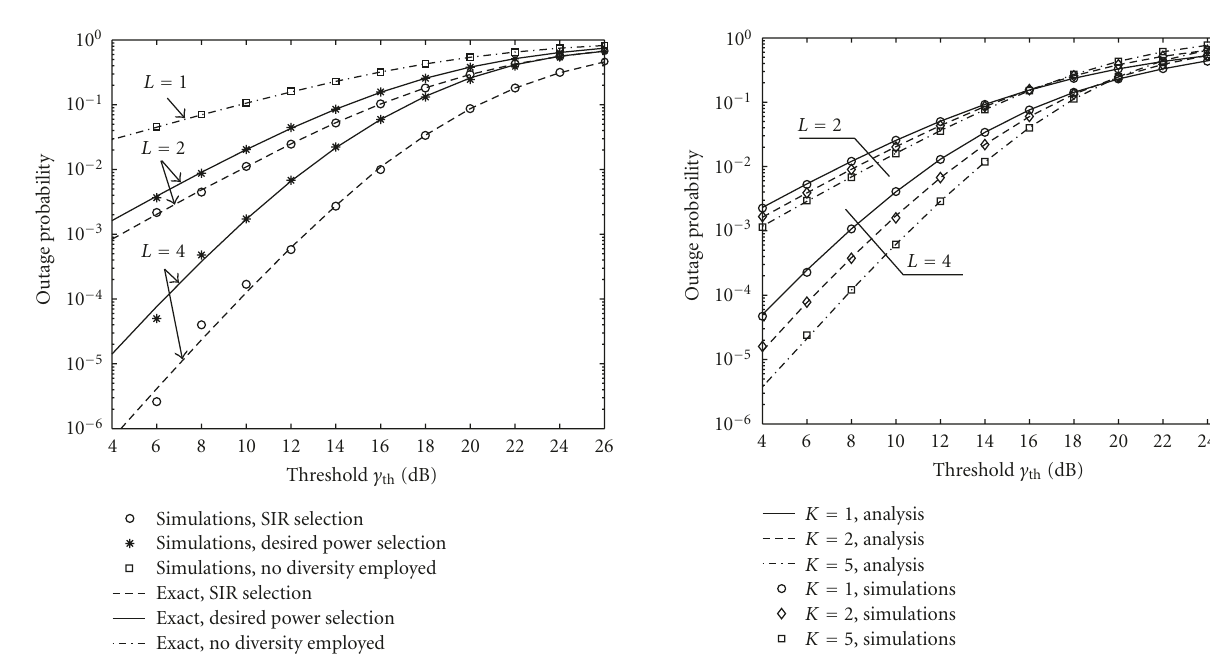
Figure 1: The e ff ect of the number of diversity branches of the SC receiver on the outage probability for m s = m I = 2, K = 2, β = 1, and SIR av = 15dB.